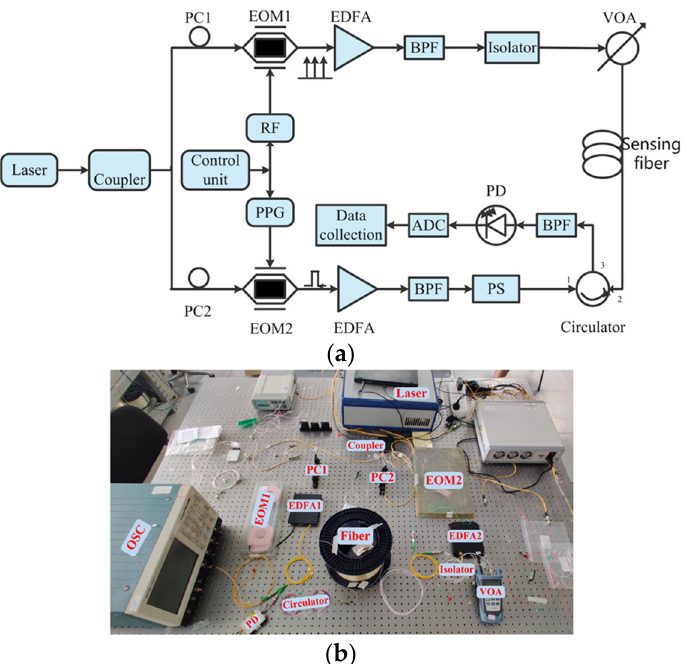
Figure 1. BOTDA distributed sensing system, ( a ) schematic diagram and ( b ) physical diagram. For a 40 km-long BOTDA high-spatial resolution monitoring system, the amount of raw data measured at one time is more than 100 m bytes, while each data acquisition time is tens of milliseconds. Network congestion from uploading original data is inevitable.